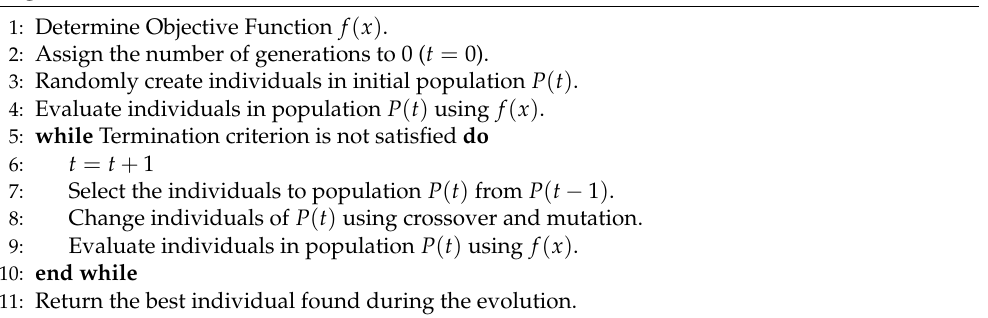
Figure 12. Flowchart of GA. Algorithm 1 Pseudo-code for